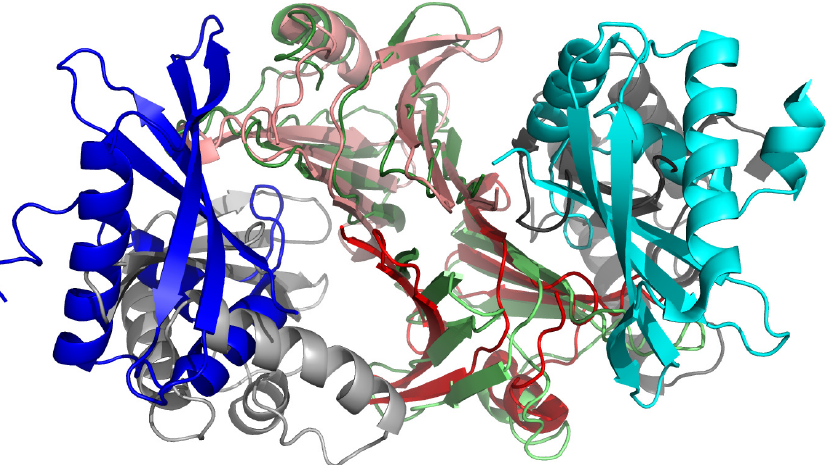
Figure 7. Cartoon representation the UNRES model of CASP13 oligomeric target H0968 obtained by the UNRES-based KIAS-Gdansk group (gray) superposed on the corresponding experimental structures (rainbow-colored). The interface RMSD is 1.33 Å and the model was ranked #1 among the models obtained by all groups. Reproduced with permission from A. Karczy´nska et al., J. Chem. Inf. Model. , 60, 1844–1864 (2020). Copyright 2020 American Chemical